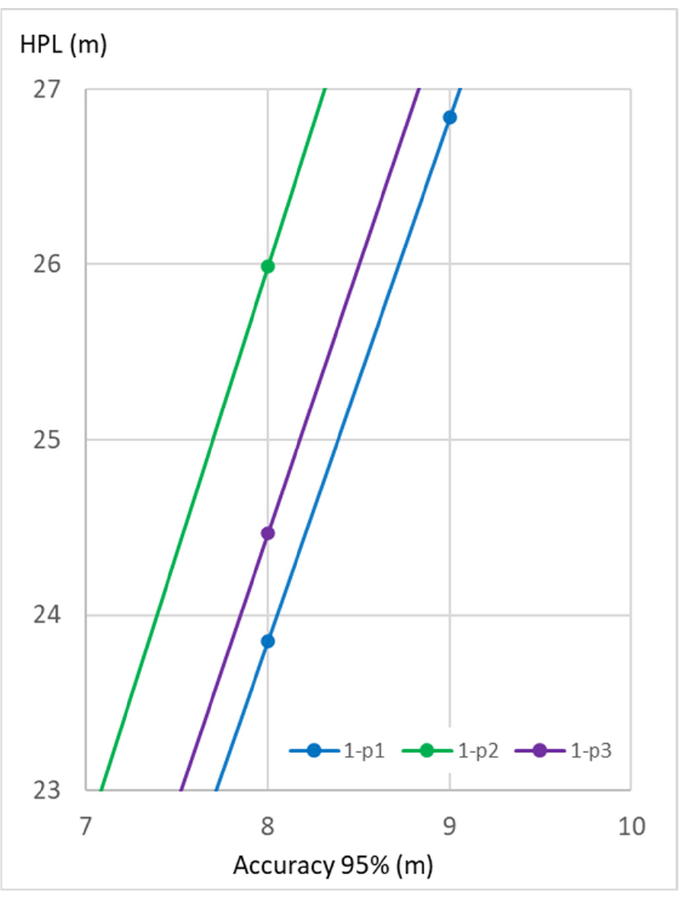
Figure 7. Dependence of HPL specified for p in Table 4 on 95% accuracy. Table 5. Dependence of HPL specified for 8 m 95% accuracy on its probability level p .